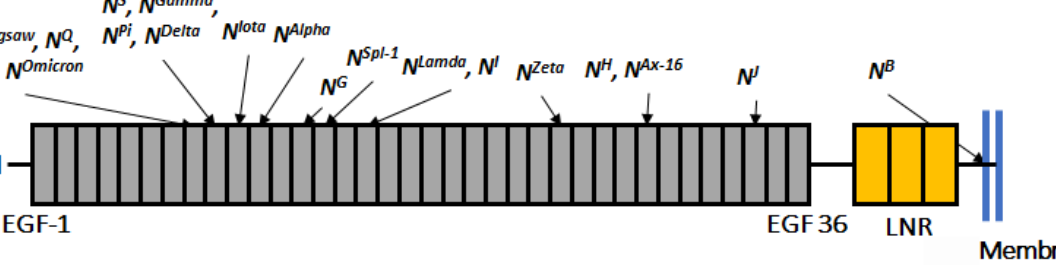
Figure 1. A schematic diagram of the Notch extracellular domain and the positions of EGF-like repeats with amino acid substitutions in Notch mutations analyzed in this study. The extracellular domain of Drosophila Notch has 36 epidermal growth factor (EGF)-like repeats (gray), three lin12/Notch repeats (LNR) (orange), and a transmembrane domain (blue lines). We investigated 19 missense mutations of Notch with amino acid substitutions in EGF-like repeats and the transmembrane domain. The mutant alleles are listed across the top, with arrows pointing to the position of the EGF-like repeat and the transmembrane domain with the substitution. EGF-like repeats are numbered in order starting with the repeat closest to the N-terminal (EGF-1).